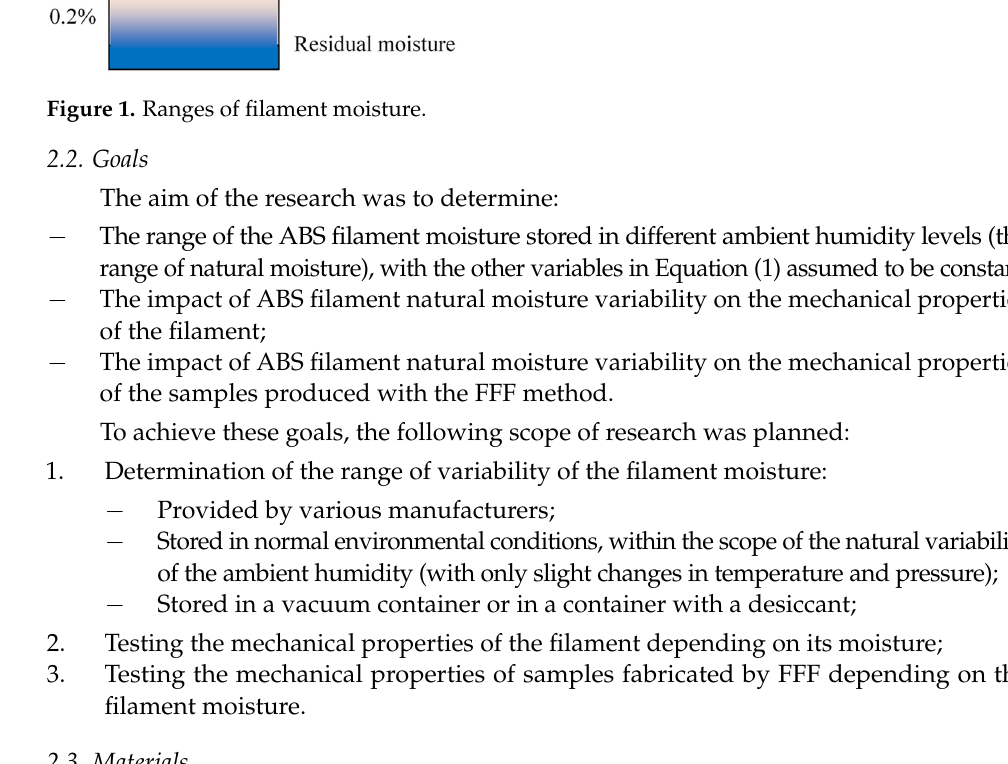
Table 2. The properties of the ABS material used in the research